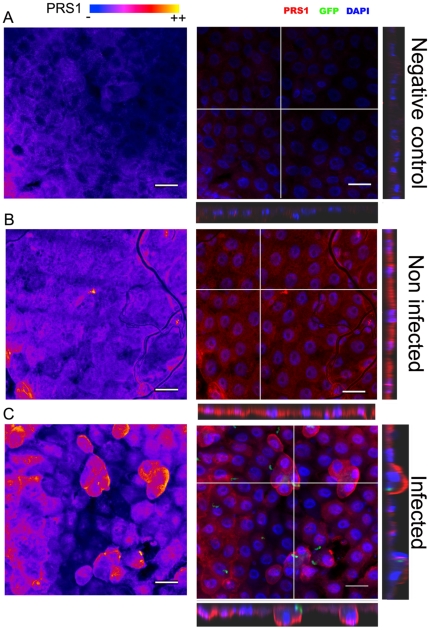
Confocal microscopy of triple-stained, infected and non-infected A. gambiae midguts.Midgut sections were incubated with preimmune serum (A) or anti-PRS1 immune serum (B and C) in the same way in parallel experiments and analyzed by confocal microscopy; the image acquisition parameters of the confocal microscope were maintained the same. In the left panels, Z-stack projections of PRS1 staining are shown in a false color representation (labeling intensity increasing from blue to yellow). In the right panels, a merge image of the three channels (red: PRS1; green: GFP-expressing ookinetes; blue: DAPI-counterstaining of the nuclei) is given according three planes: z-stack projection of the xy planes (main image), xz and yz cross-sections according to the directions marked by the white lanes on the main image. A: Control midgut stained with preimmune serum. B. Mosquito midgut, 24 h after a non-infective blood-meal. C. Mosquito midgut 24 h after feeding on a P. berghei-infected mouse. Note the higher intensity in PRS1 labeling in the proximity of ookinetes, as well as the relocalization of PRS1 in the cell periphery of cells protruding towards midgut lumen. Bar: 20 µm.